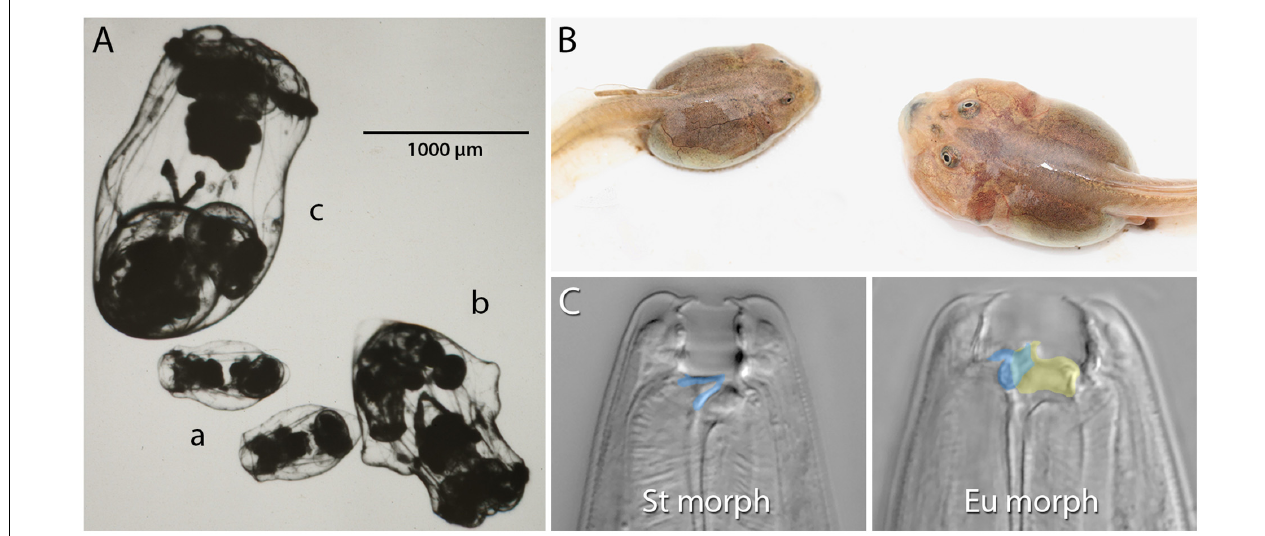
FIGURE 1 | Examples of resource polyphenism. (A) Preserved saccate (a), cruciform (b), and campanulate (c) females of the rotifer Asplanchna sieboldii . These forms differ in their ability to capture and consume large prey items. (B) Omnivore (left) and carnivore (right) spadefoot toad ( Spea multiplicata ) tadpoles. In addition to the obvious size and jaw musculature differences, carnivores possess a shorter gut, more highly keratinzed mouthparts, and overall activity. Omnivore tadpoles primarily feed on detritus, but carnivores specialize on fairy shrimp and other tadpoles. (C) The stenostomatous (St morph) and eurystomatous (Eu morph) mouth forms of the nematode Pristionchus pacificus . False coloring indicates how the morphs differ in the shape of the dorsal tooth (blue) and the presence of an additional, opposing tooth (yellow). Whereas St worms are microbivores, Eu worms are omnivores capable of consuming both microbes (e.g., yeast, bacteria) and other nematodes. Image in (A) is courtesy of John J. Gilbert and reproduced from Gilbert (2017) with permission from John Wiley and Sons (© 2016 Cambridge Philosophical Society). Image in (B) is courtesy of David W. Pfennig and modified from Levis et al. (2020). Images in (C) are by Erik J. Ragsdale and from Bui et al. (2018).